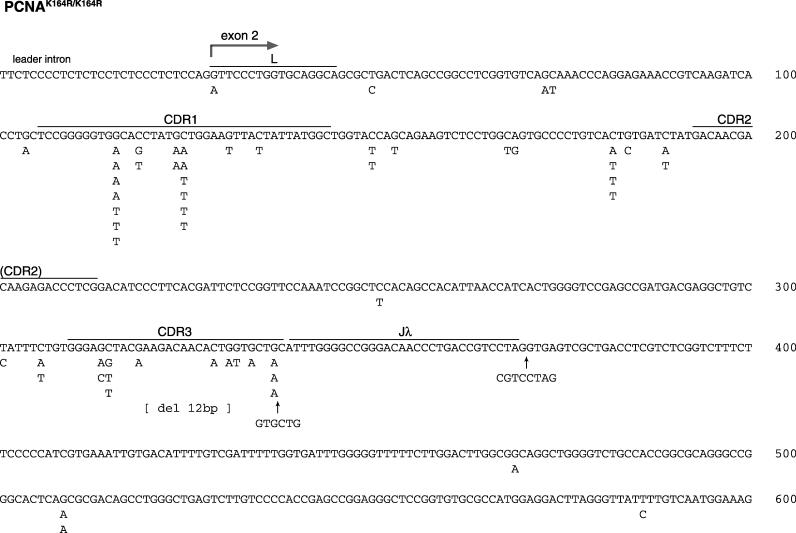
Ig Hypermutation of the PCNAK164R/K164R CloneIg light-chain sequence variation in the PCNAK164R/K164R clone. All sequence differences in the region from the first intron to the J-C intron are shown relative to the rearranged light-chain consensus sequence of the AIDRψV− precursor clone. The position of complementary determining regions CDR1, CDR2, and CDR3 and that of Jλ are indicated.